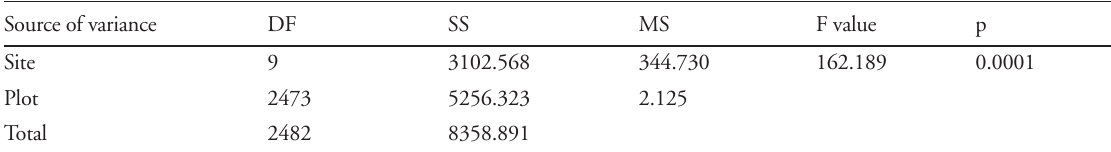
Table 3. Statistics (ANOVA) of resin production in the experimental sites. Source of variance